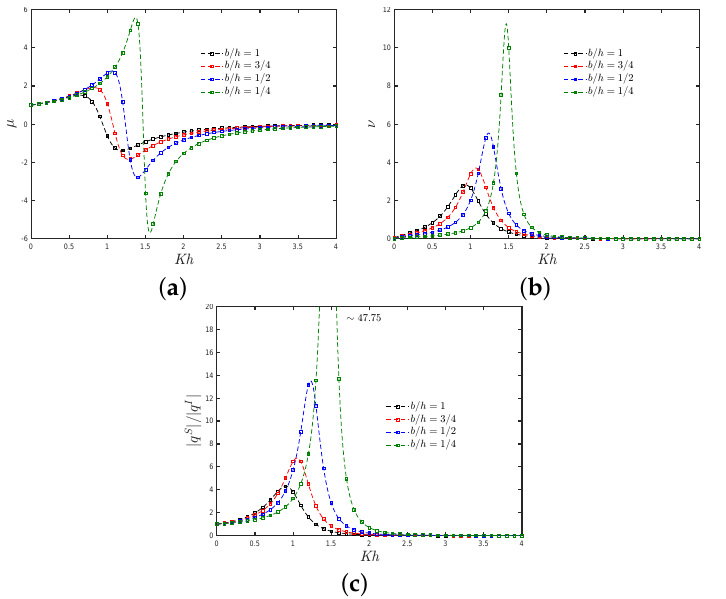
Figure 7. The influence of chamber length b / h on the ( a ) radiation susceptance coefficient, ( b ) radi- ation conductance coefficient and ( c ) non-dimensional induced volume flux due to the scattering potential against Kh with a 1 / h = a 2 / h = 1/2 and w 1 / h = w 2 / h =